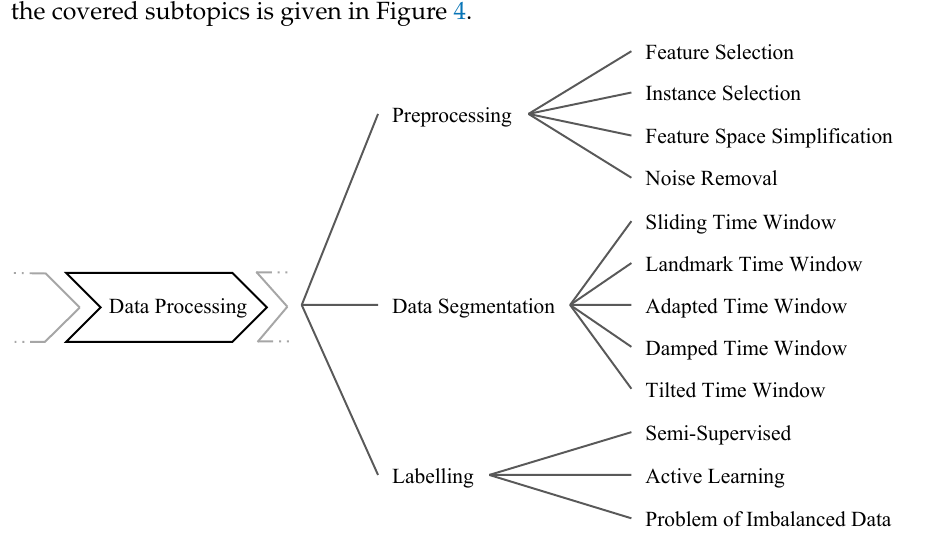
Figure 4. Overview of data preparation methods applicable for data stream classification purposes. Here, the handling of data of the respective sources is